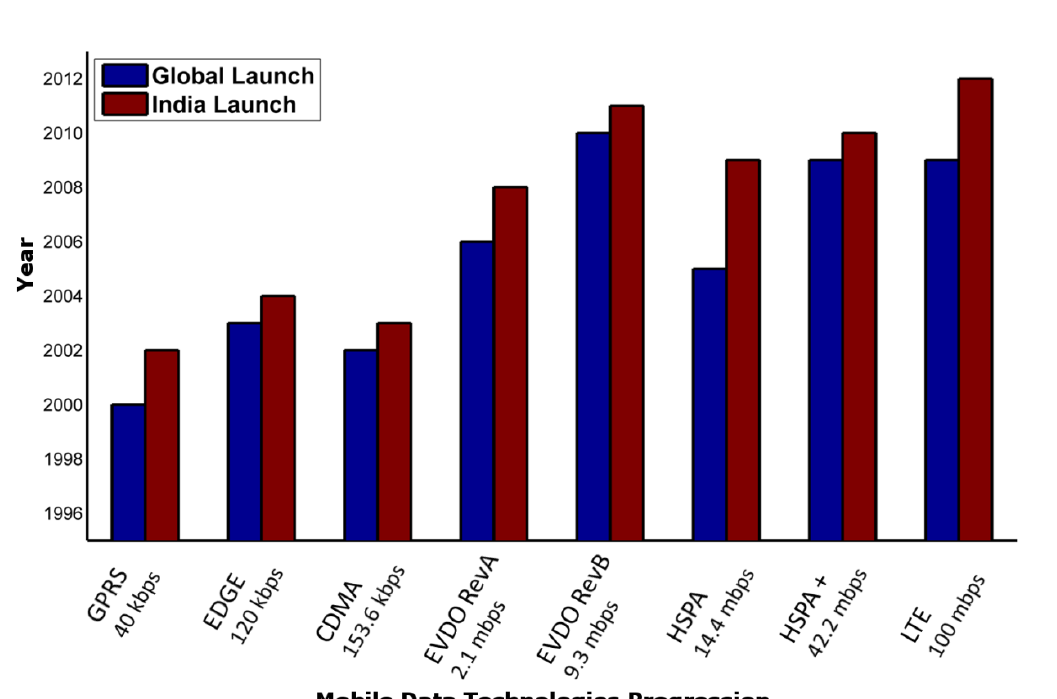
Figure 1: The trend of wireless technology (data speed) deployment in India and worldwide from 1996 to